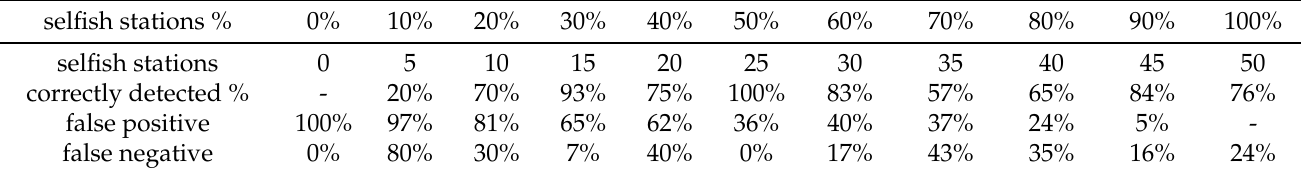
Table 3. Principal-agent detection method for 50 stations and 2 slots in TCP firmware scenario.